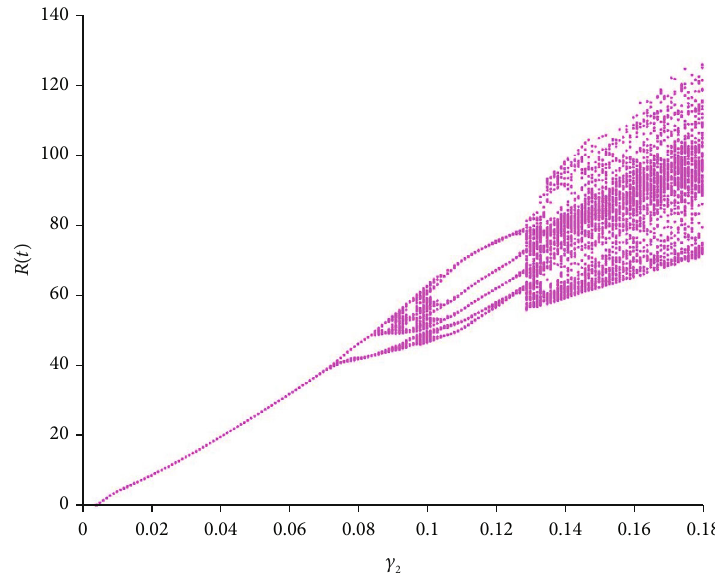
0 < γ ≤ 0 : 18 and other default parameter values and with assumed 2 of model (1) for 2